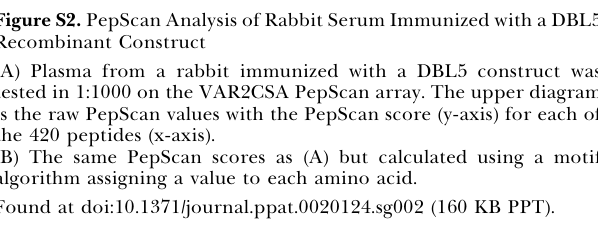
Figure S2. PepScan Analysis of Rabbit Serum Immunized with a DBL5 Recombinant Construct (A) Plasma from a rabbit immunized with a DBL5 construct was tested in 1:1000 on the VAR2CSA PepScan array. The upper diagram is the raw PepScan values with the PepScan score (y-axis) for each of the 420 peptides